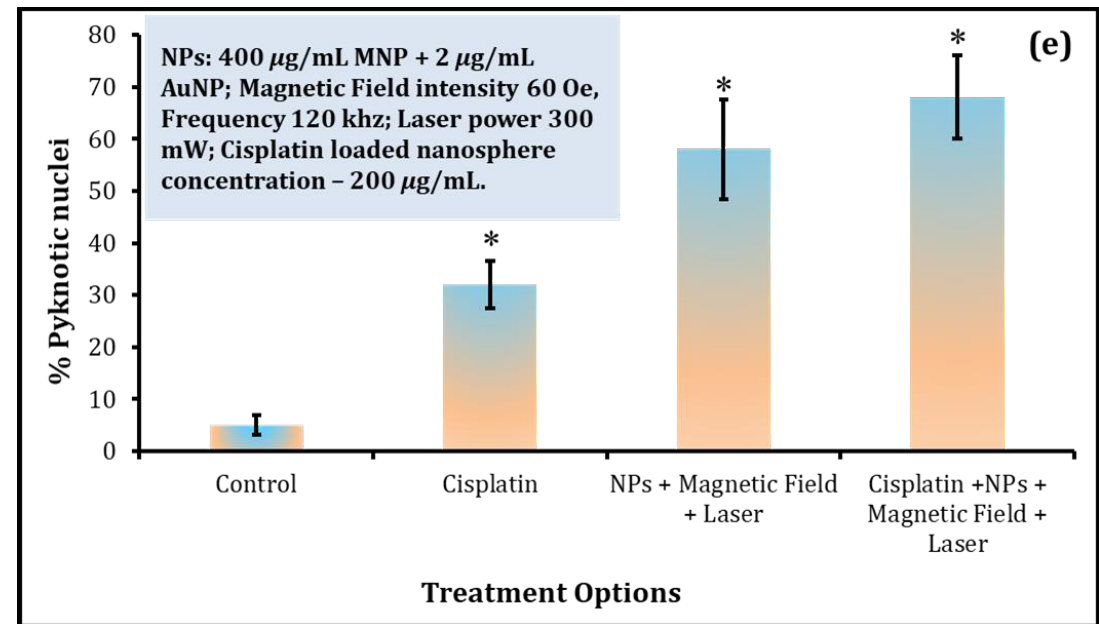
Figure 6. Nuclear condensation and fragmentation (white arrows) under the following conditions: ( a ) control, ( b ) presence of 200 µg/mL CPNPs, ( c ) combined optical-AC magnetic field irradiation in the presence of NPs (400 µg/mL MNP + 2 µg/mL AuNP), and ( d ) combined optical-AC magnetic field irradiation in the presence of NPs and CPNPS. AC Magnetic field intensity was 60 Oe, frequency was 120 kHz, and laser power was 300 mW (at 520 nm). Scale bar is 10 µm in ( a ), and is also applicable for ( b – d ). ( e ) Bar chart displaying quantification of pyknotic nuclei, indicative of cell death. Data are means ± SEM from four separate experiments and * indicates statistically significant differences, compared to cells cultured as the control, at p < 0.01 (ANOVA and LSD post-hoc).